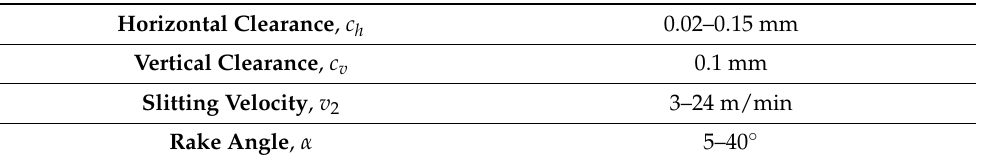
Table 2. The ranges of the variability of the studied